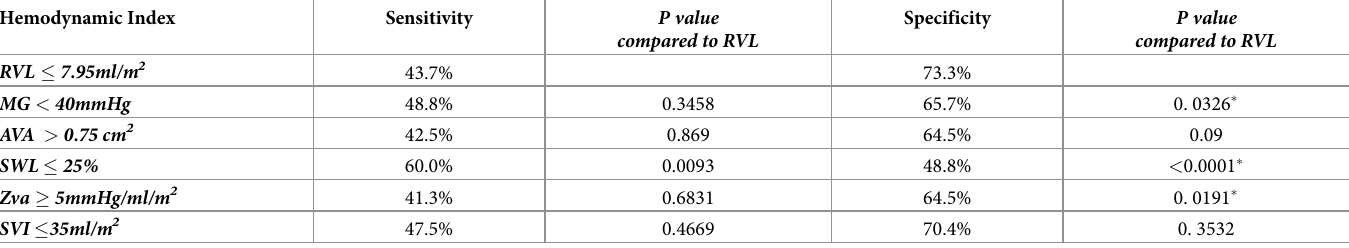
Table 8. Comparison of the sensitivity and specificity of hemodynamic indices for predicting the combined outcome of all cause mortality or cardiovascular re- admission 1-year post-TAVR. Hemodynamic